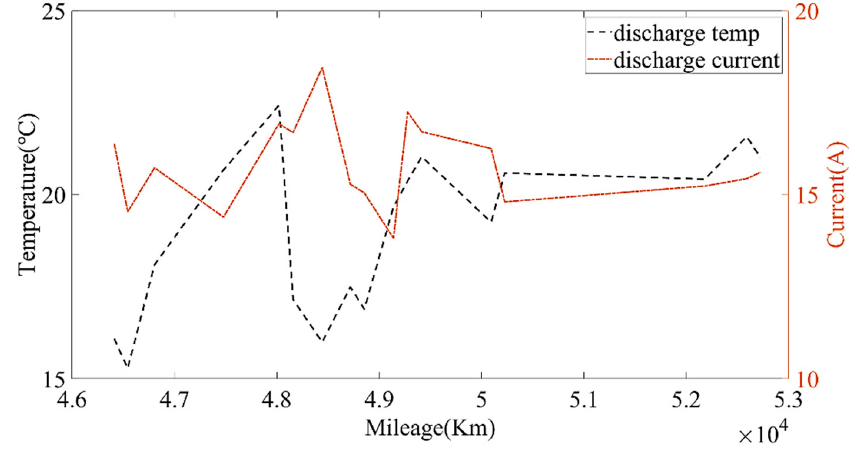
Figure 14. The relationship between the discharging temperature, discharging current and the mileage at the charging temperature of 23 °C.